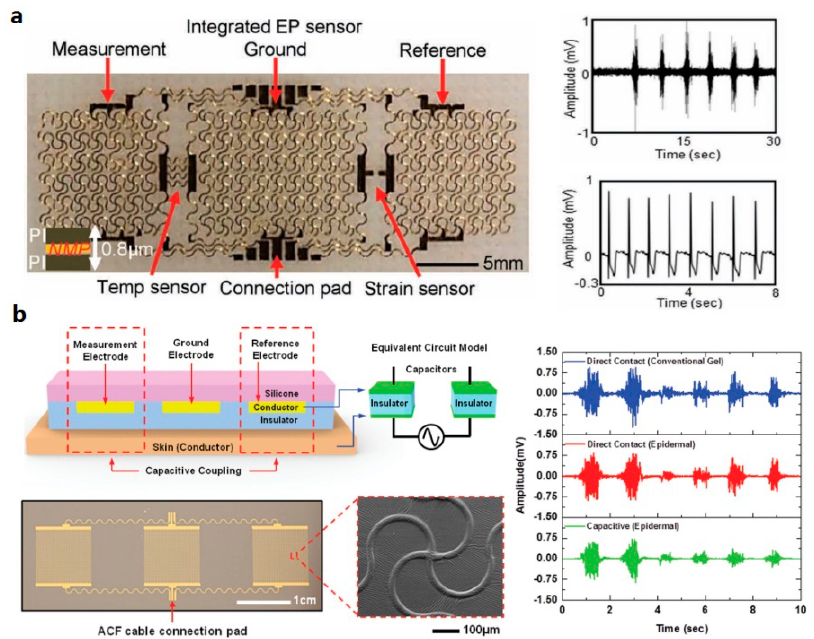
Figure 5. Examples of skin sensors for biopotential measurement: ( a ) biopotential measurement using skin-contacted metallic electrodes (Reprinted with permission from Ref. [91] Copyright 2013 John Wiley and Sons); and ( b ) an epidermal electronic system (EES) with a capacitive sensor for electrophysiological (EP) measurement (Reprinted with permission from Ref. [18] Copyright 2014 John Wiley and Sons).